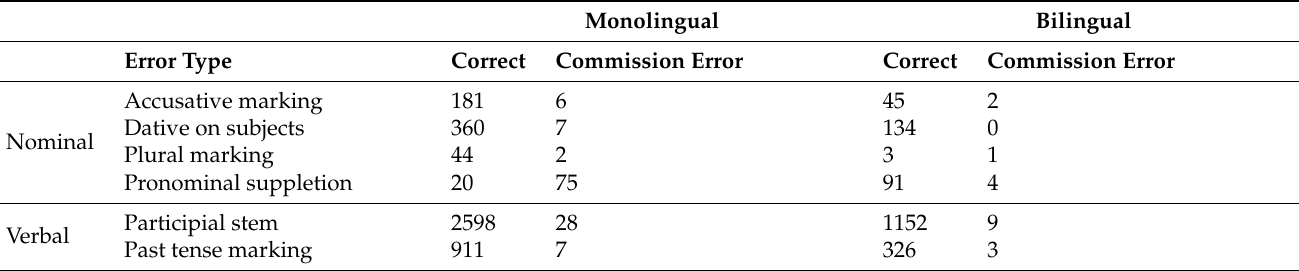
Table 2. Token frequencies of correct instances vs commission errors in the